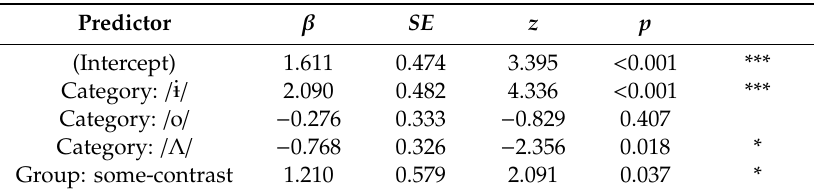
/ overall), / o / with / Λ / , and / Λ / with / a / . Relatively few errors involved confusion with / or / e / . In short, vowel identification errors tended to involve confusion with a vowel sharing a specification for roundedness / labiality and / or height, which was unsurprising; however, predominant vowel confusions were not symmetrical (e.g., / o / was most often misidentified as / Λ / but / Λ / was not most often misidentified as / o / ). Languages 2020 , 5 , x FOR PEER REVIEW